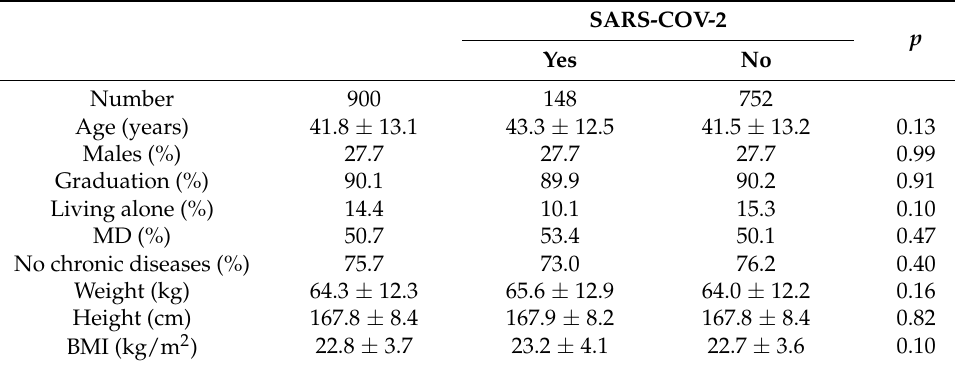
Table 1. Characteristics of the participants.